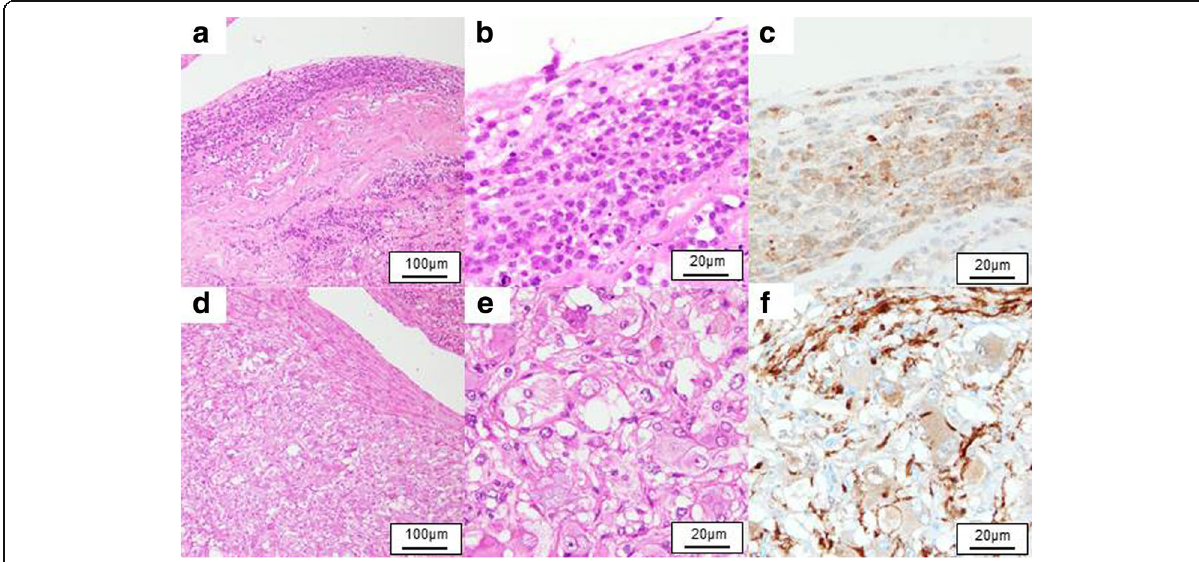
Fig. 3 Microscopic findings. Microscopically, two types of atypical cells with enlarged heterozygous nuclei are observed in a part of the cyst wall. a – c Neuroblastic cells immunohistochemically positive for neuron-specific enolase [ a hematoxylin/eosin (HE), × 100 magnification; b HE, × 400 magnification; and c neuron-specific enolase, ×400 magnification]. d – f Cells morphologically similar to ganglion cells and immunohistochemically